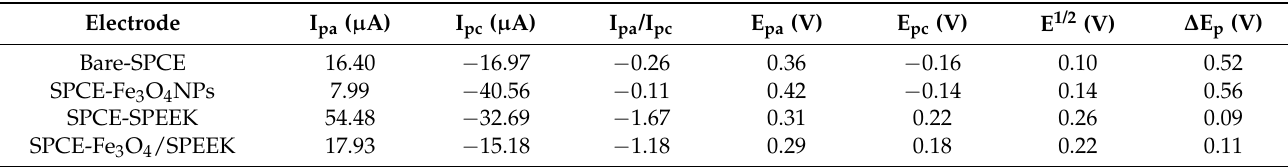
Table 1. Summary of cyclic voltammetric data recorded at different unmodified and modified electrodes in K 3 [Fe(CN) 6 ] solution.